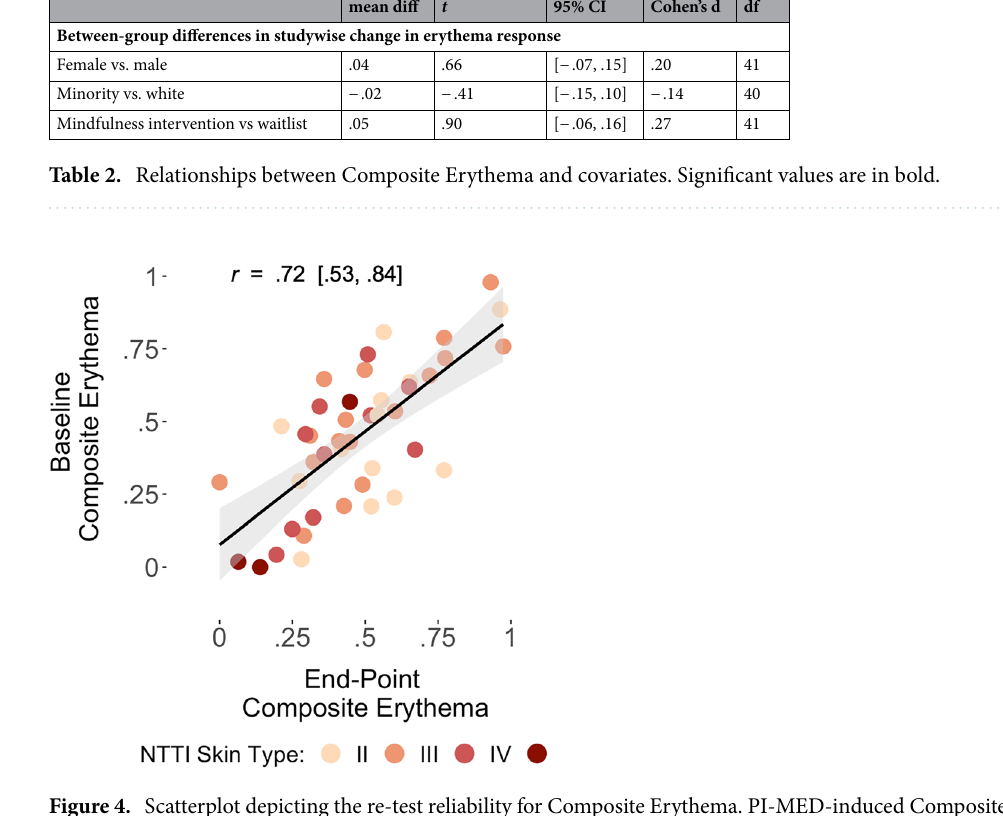
Figure 4. Scatterplot depicting the re-test reliability for Composite Erythema. PI-MED-induced Composite Erythema showed good test–retest reliability between the baseline and end-point measurements ( r = .72, 95% CI = [.53, .84]). The four skin types included in the sample appeared well-distributed, suggesting the PI-MED procedure reliably induced erythema across different skin pigmentation